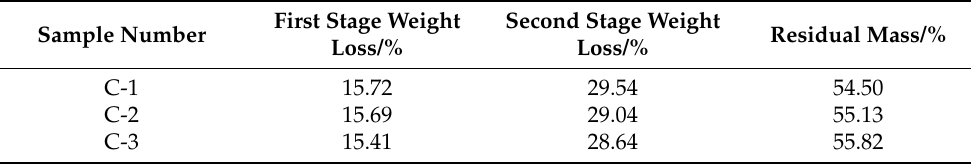
Table 3. Weight loss and residual mass in two pyrolysis